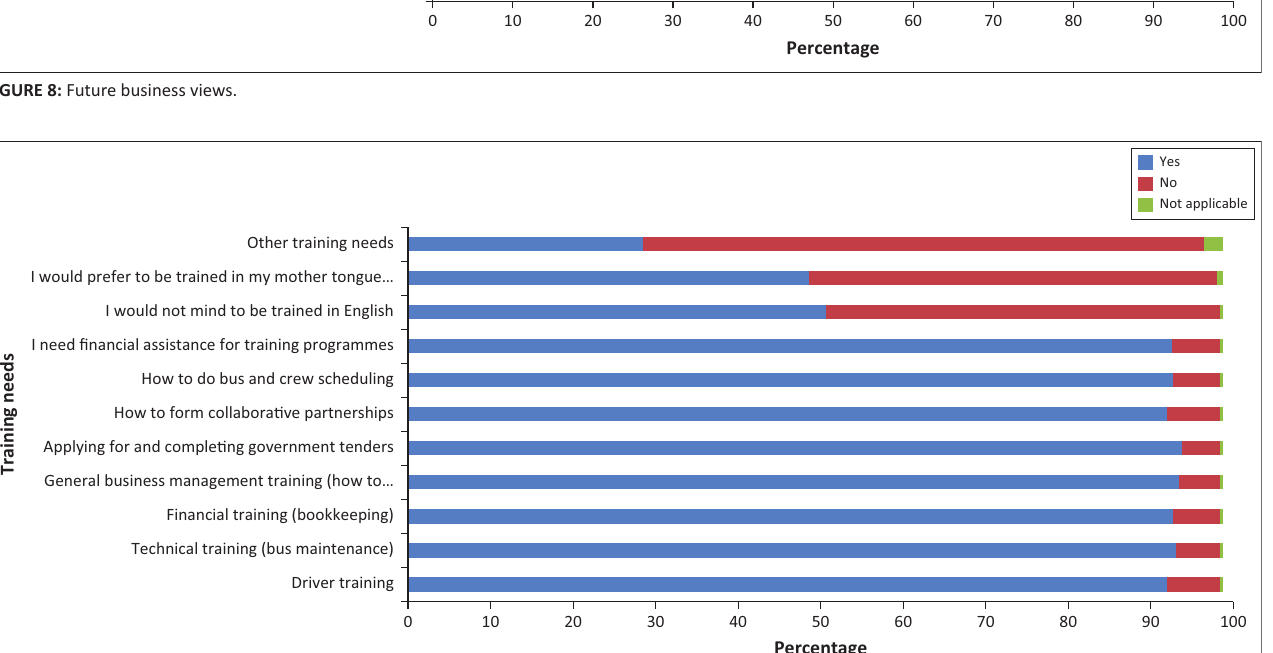
maintenance)Financial trainingTechnical training (bus Driver